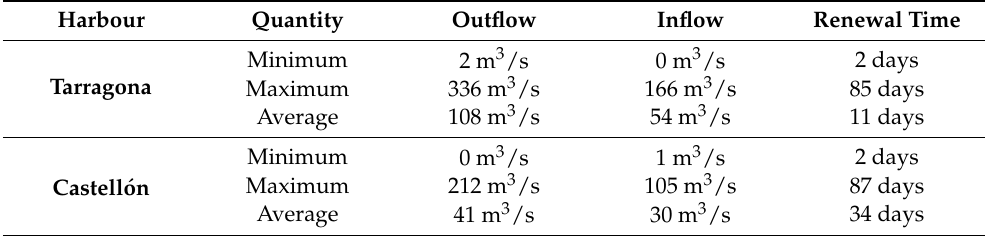
Table 6. Flows and Renewal Times (RT) calculated for Tarragona and Castell ó n harbours from measured Doppler velocities during the field campaigns.